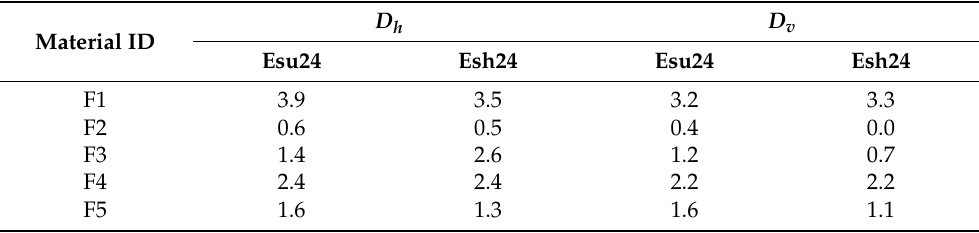
Table 4. The changes in horizontal ( D h ) and vertical density ( D v ) due to aging (in %). Material ID